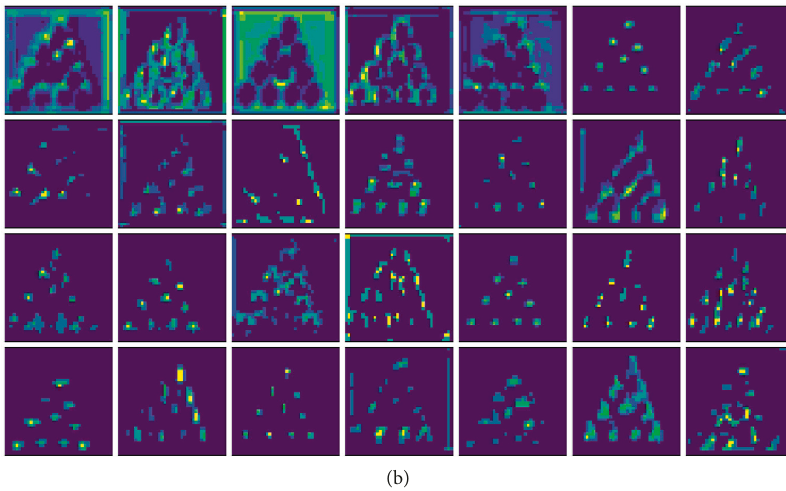
Figure 7: Comparison of SSD algorithm feature map detection. (a) SSD. (b) FPEF-SSD.